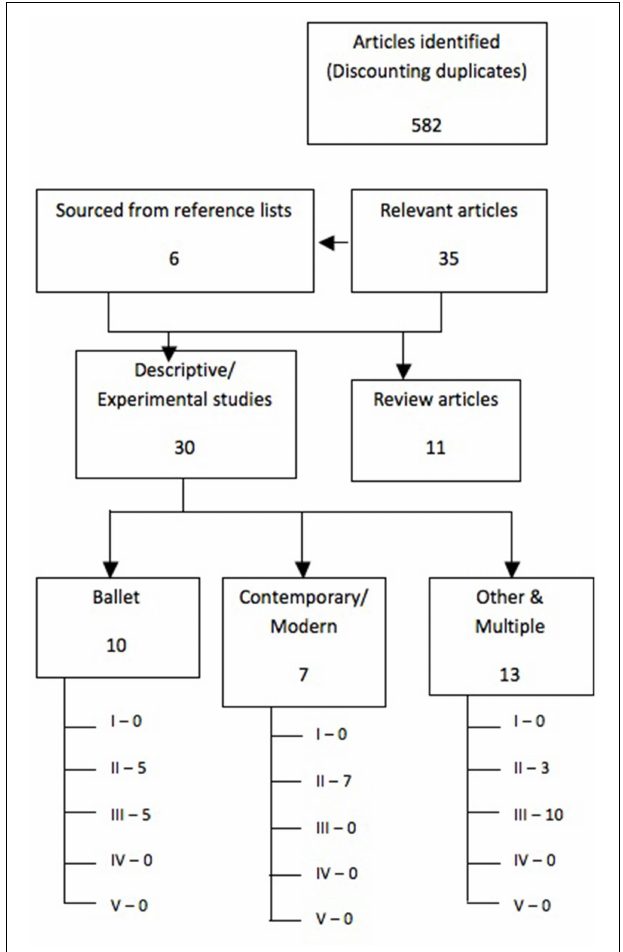
FIGURE 1 | Flow-diagram depicting the process of article identification and